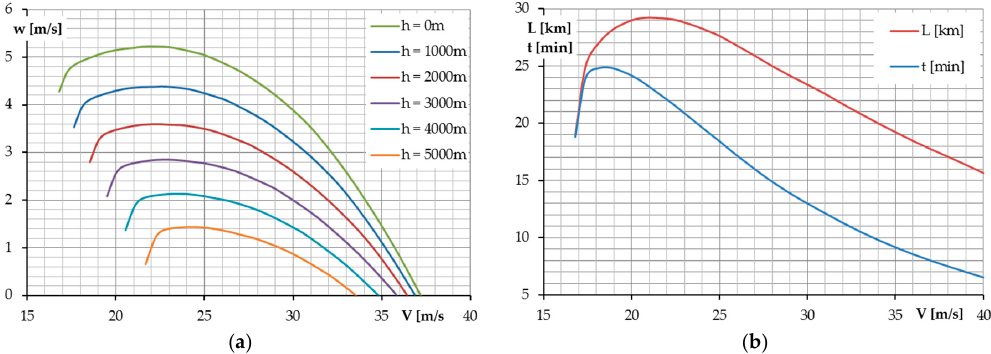
Figure 4. ( a ) Maximum climb rate versus airspeed for several flight altitudes; and ( b ) maximum range and endurance versus airspeed for simple cruise mission.